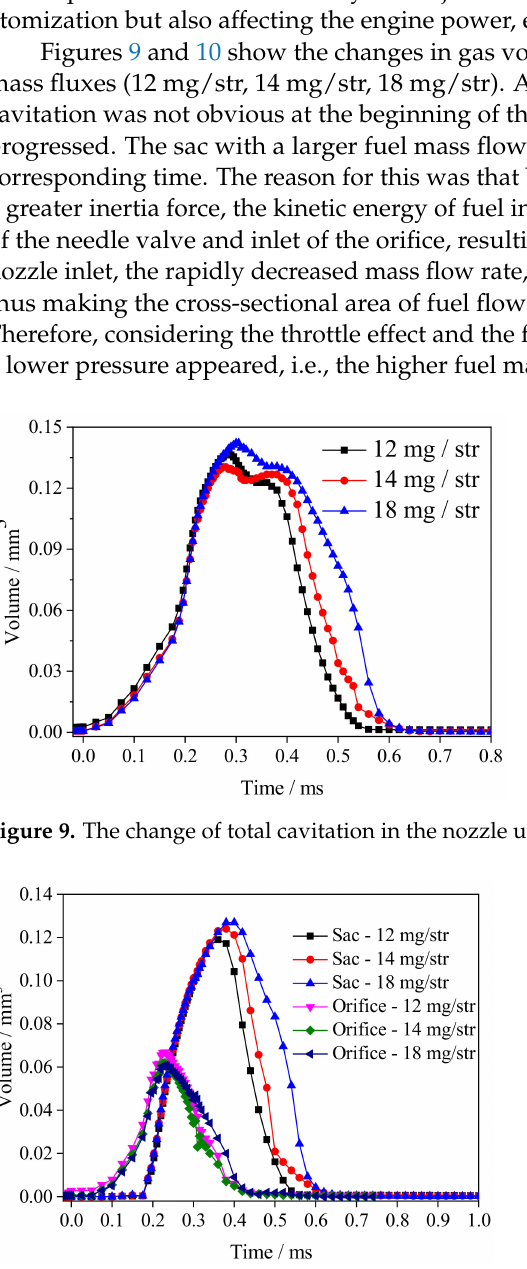
Figure 10. The change of cavitation under different mass